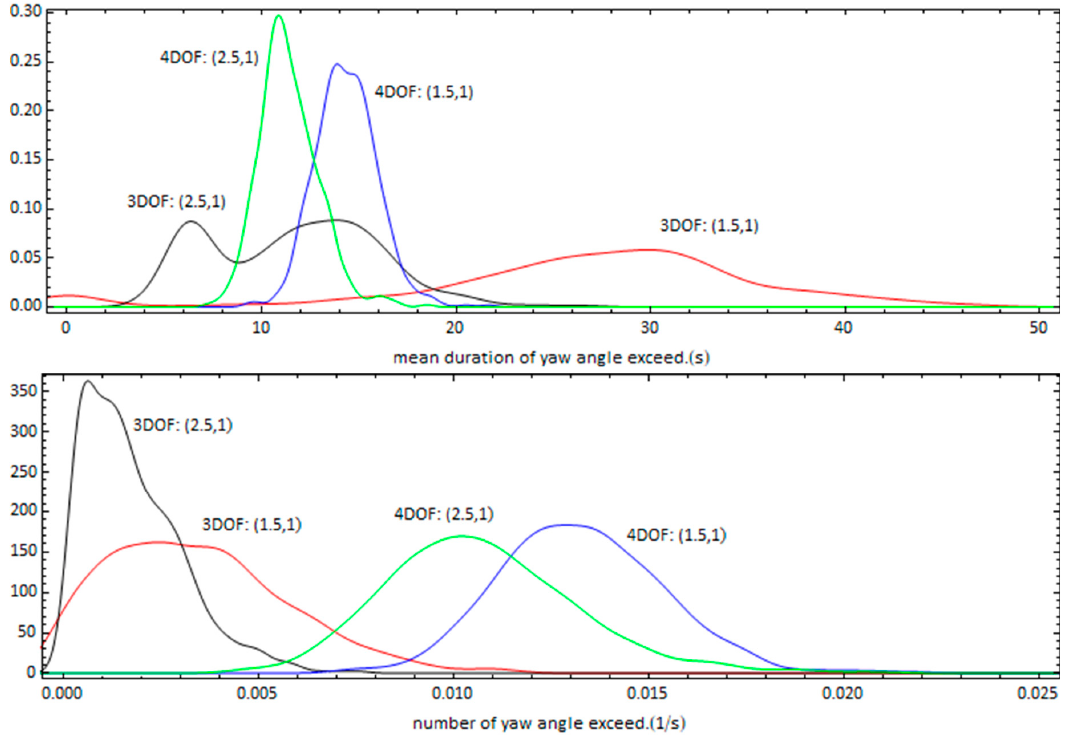
Figure 17. Estimates of the probability density functions for the mean duration of yaw exceedance (up) and the number of yaw exceedances per unit time (down) for different control gains’ options ( K 1 = 1.5, K 2 = 1s − 1 , and K 1 = 2.5, K 2 = 1s − 1 ). J. Mar. Sci. Eng. 2020 , 8 , x FOR PEER REVIEW